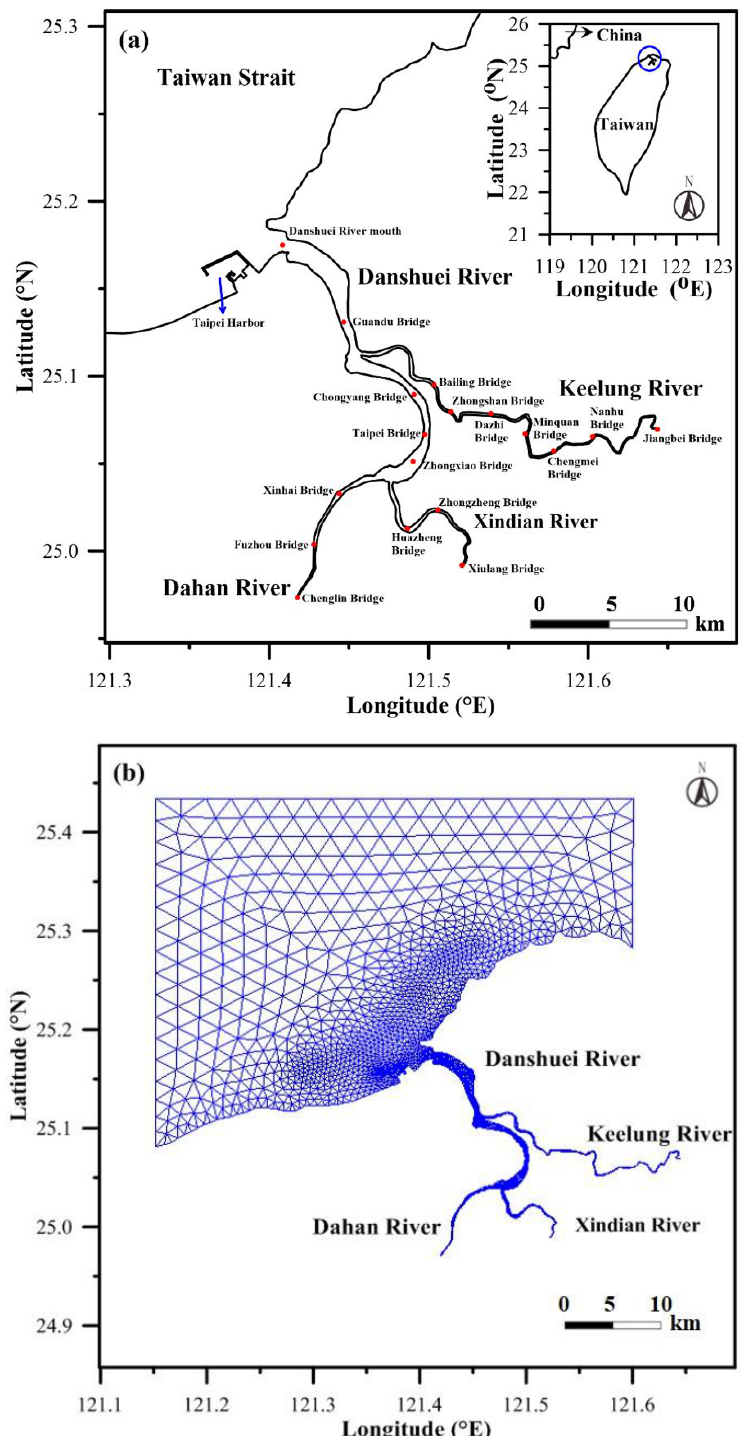
Figure 1. ( a ) Map of the Danshuei River estuarine system including the Danshui River–Dahan River, Xindian River, and Keelung River and the adjacent coastal seas, and ( b ) unstructured grid of the horizontal dimensions in the computational domain for the SCHISM model simulations.